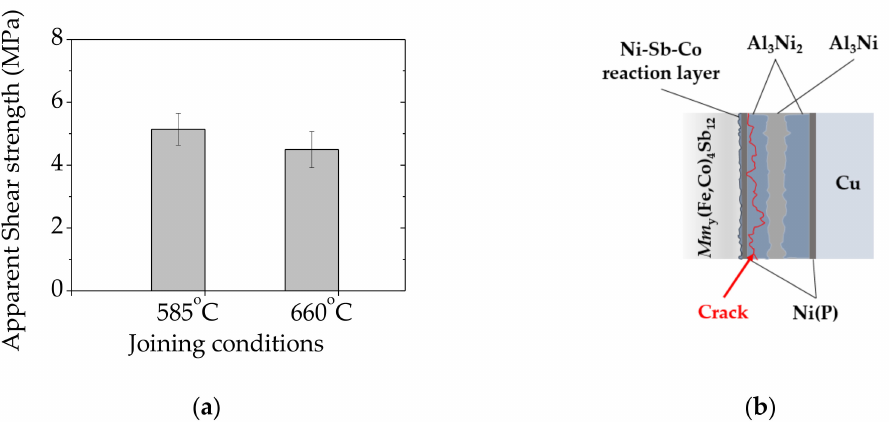
Figure 5. Mechanical performance of bonded specimens: ( a ) Apparent shear strength of interconnect– Mm y (Fe,Co) 4 Sb 12 interfaces formed at different joining temperature and ( b ) the schematic illustration with fracture mode of sheared assembly marked in